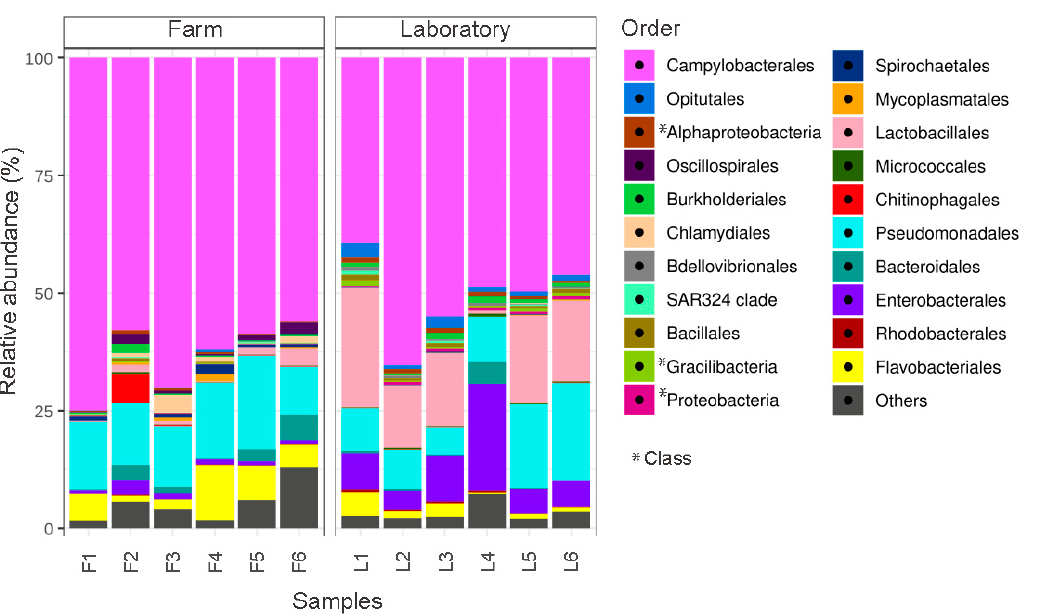
Figure 1. Comparison of relative abundances of bacterial groups in Argopecten purpuratus gills between scallops maintained under farm and laboratory conditions. Stack bar graphs indicate the average relative abundance of major bacterial orders found in the farm and laboratory-maintained scallops ( n = 10 pooled individuals per sample).